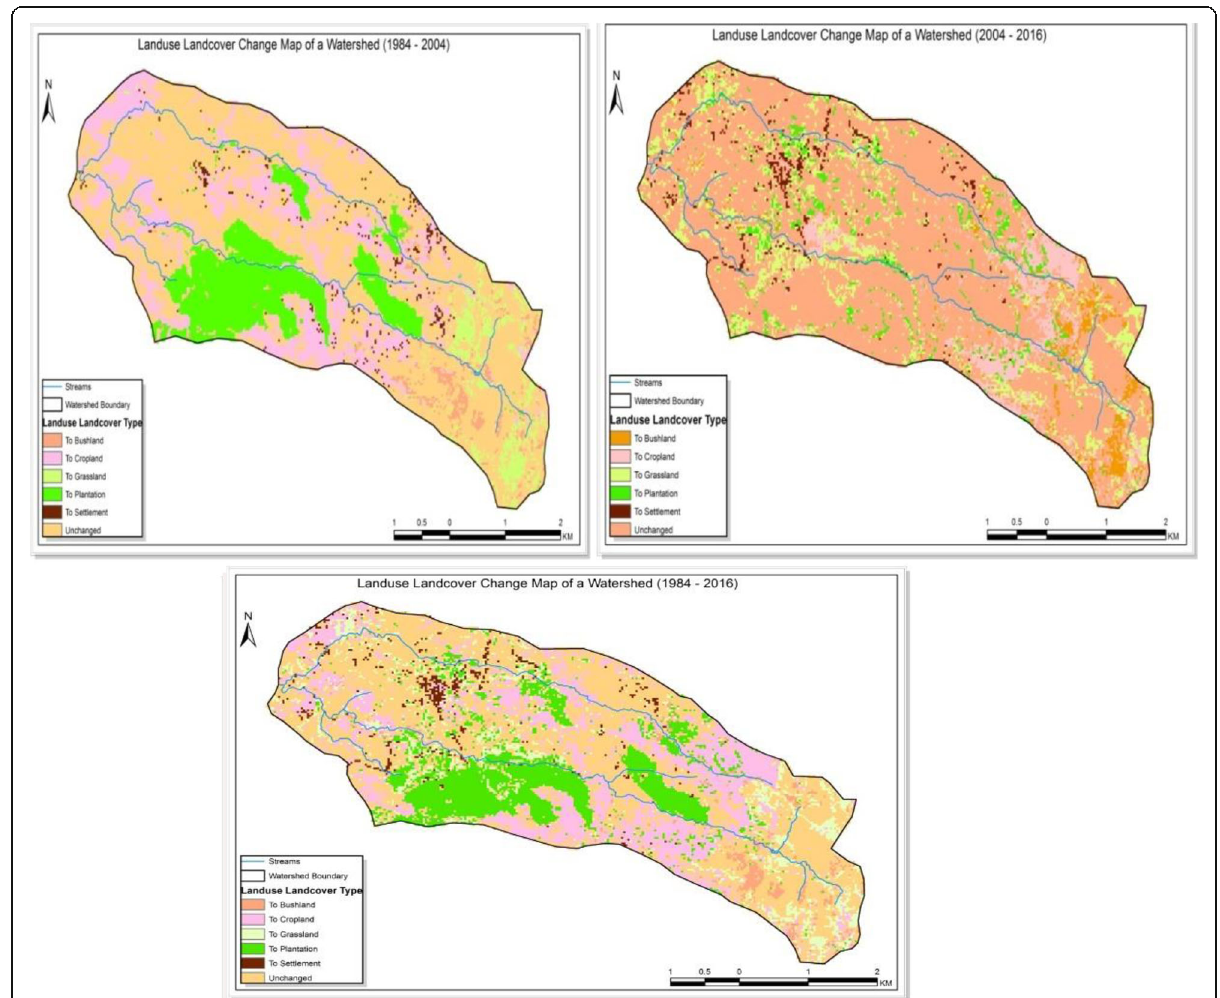
Fig. 2 LULC maps of the watershed in 1984, 2004, and